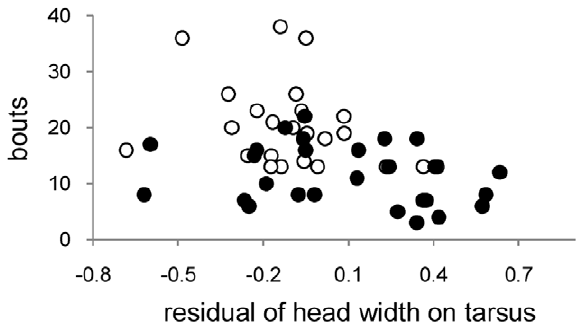
Figure 3. Relationship between residuals of the regression of head width on tarsus (day 175) and bouts taken to pass the learning task. (White circles–LO diet birds; black circles – HI diet birds. For statistical effect, see Table 3. )